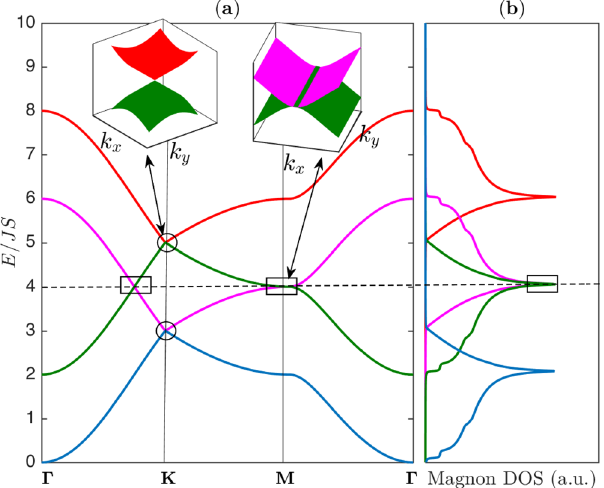
Figure 3. The magnon energy bands and magnon density of states. ( a ) Magnon band structures with coexistence of magnon Dirac-nodal lines (rectangular boxes) and magnon Dirac points (circles) along the Brillouin zone paths in Fig. 1(b). The dashed line corresponds to the energy of Dirac magnon-nodal lines at E = E 0 . The inset shows the 3D bands near M for the Dirac magnon-nodal lines and near K for the Dirac magnon points respectively as indicated by the same colour codes of the 2D bands. ( b ) The corresponding magnon density of states (DOS). The plots are generated by setting J L = 0.8 J